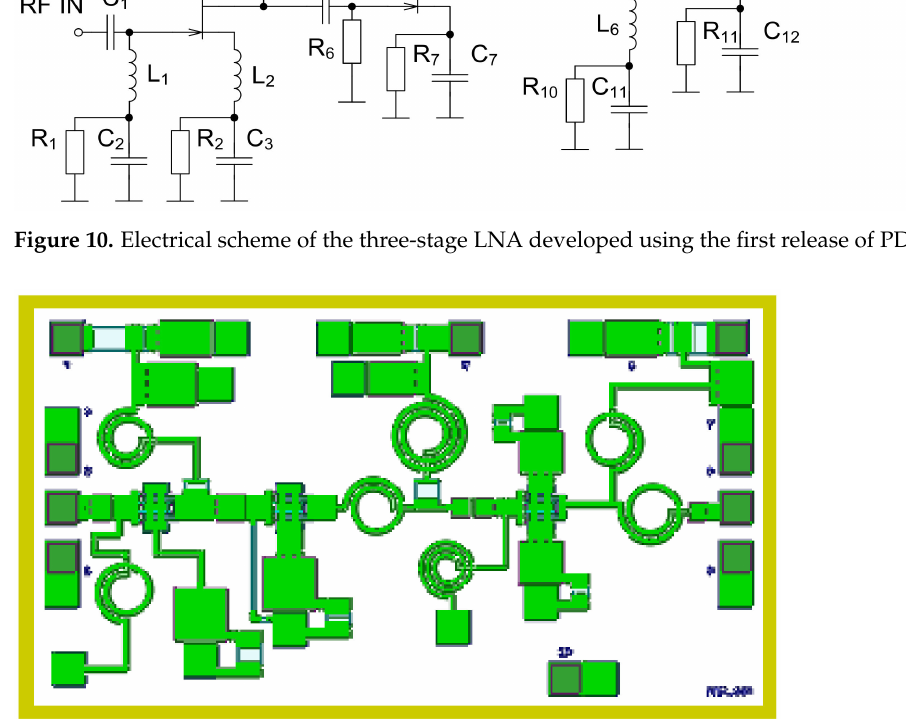
Figure 11. Designed topology of the three-stage LNA developed using the first release of PDK.